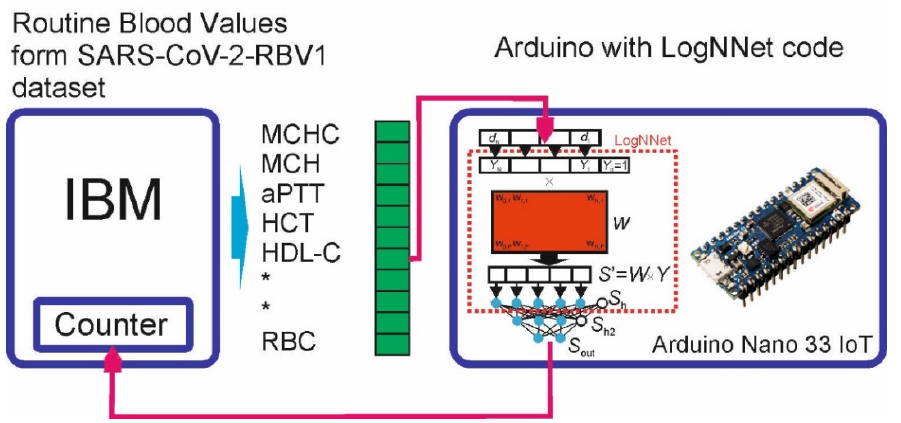
Figure 1. Arduino Nano 33 IoT test circuit and LogNNet architecture.